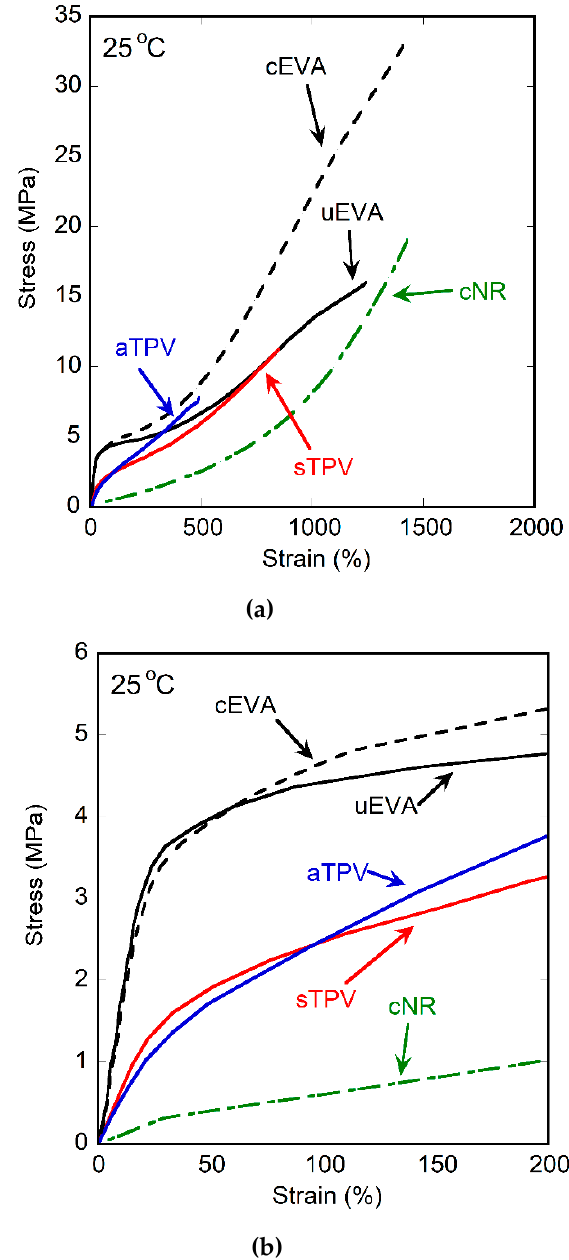
Figure 6. Stress–strain curves of uncured EVA, cured EVA, cured NR, and EVA/NR TPVs at ( a ) overall ( b ) 0–200% strain. Table 3. Tensile properties and tension set of pure EVA, cured NR, and EVA/NR TPVs samples prepared with different methods.